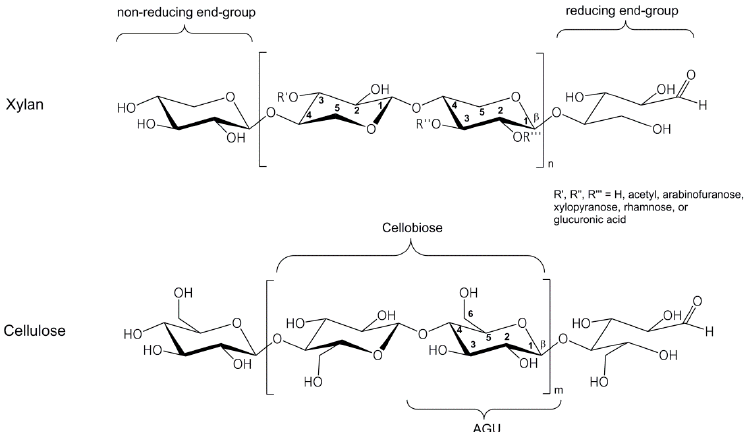
Figure 1. Structure of a xylan from annual plant [9] in comparison to cellulose; in both polymers the monomer units are linked together by β -(1 → 4) glycosidic bonds; AGU = anhydroglucose unit.